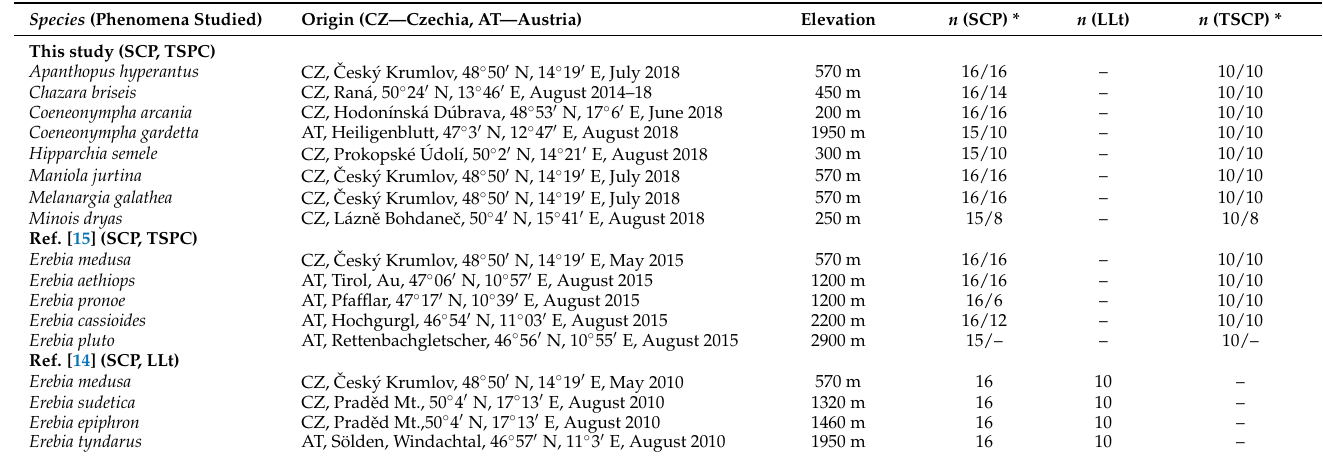
Table 1. Overview of the Satyrinae butterflies analyzed, including Erebia butterflies from earlier studies [14,15]. Localities and dates of sampling, their respective elevation, and numbers ( n ) of larvae used to assess supercooling point (SCP), lower lethal temperature (LLt), and total sugar and polyol concentration (TSPC). * The two numbers separated by “/” denote the numbers of larvae used for Autumn/Winter